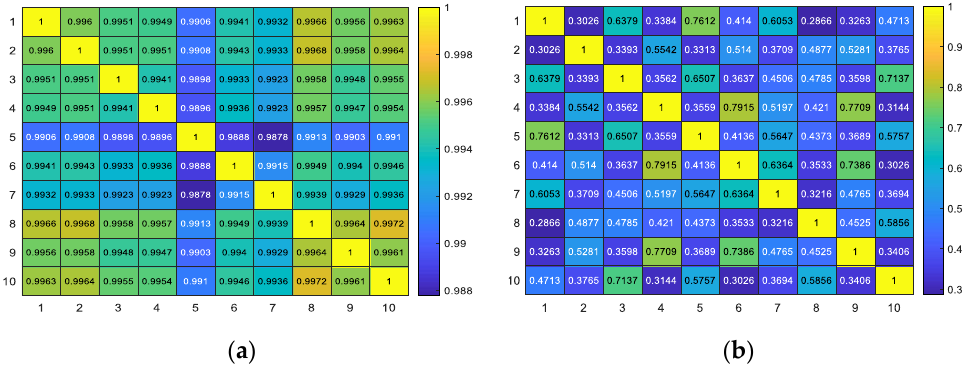
Figure 8. Correlation coefficient matrix of directional images based on WLD and WTLD. ( a ) Correlation coefficient matrix of directional images based on WLD; ( b ) correlation coefficient matrix of directional images based on WTLD.